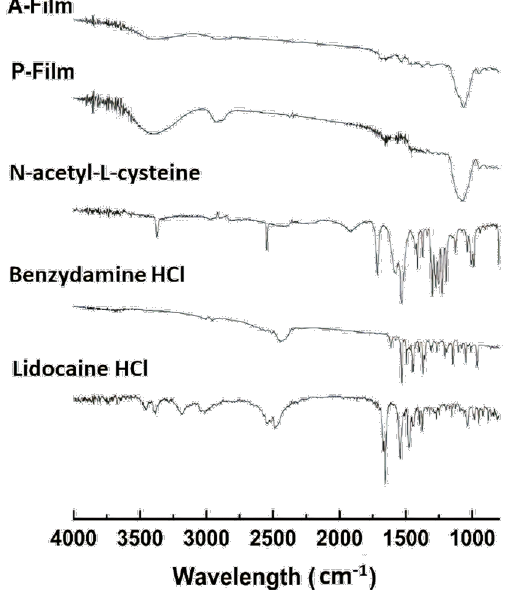
Figure 6. Fourier Transform Infrared Spectroscopy (FTIR) spectra of A-film (with drugs), P-film (without drugs), and pure drugs (Lidocaine HCl, Benzydamine HCl, and N -acetyl-L-cysteine) are shown.